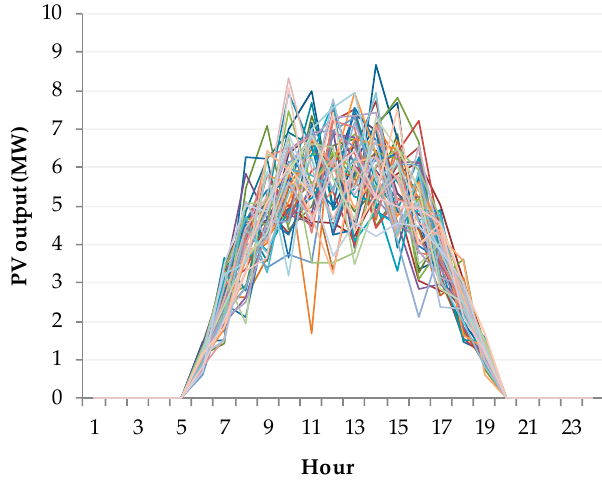
Figure A3. Fifty PV power output scenarios randomly generated (Case 1).